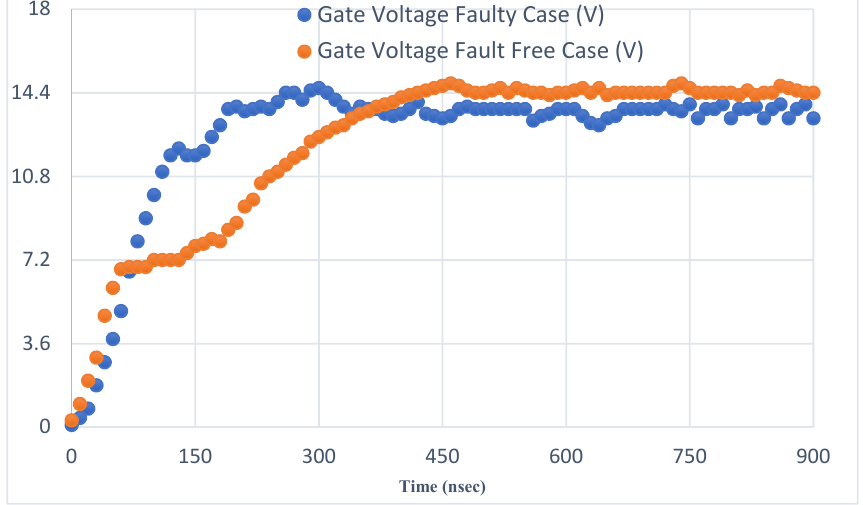
Figure 23. CM technique based on switching time [56].